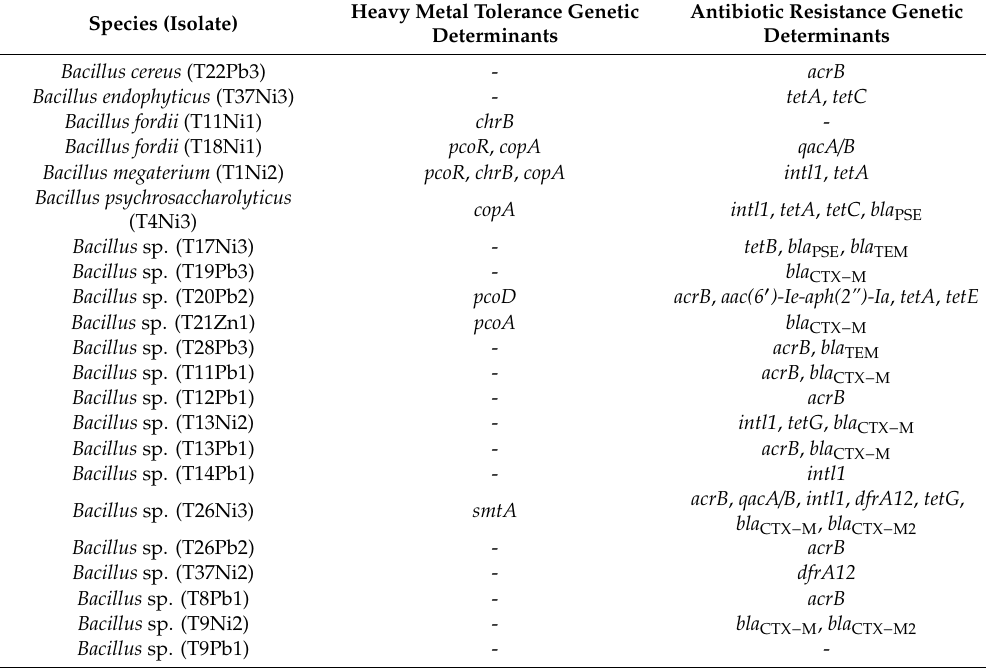
Table 1. Genetic determinants of heavy metal tolerant isolates from agricultural